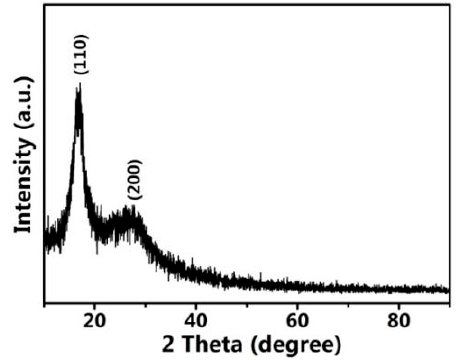
Figure 4. XRD pattern of the PAN-nanofiber membranes.